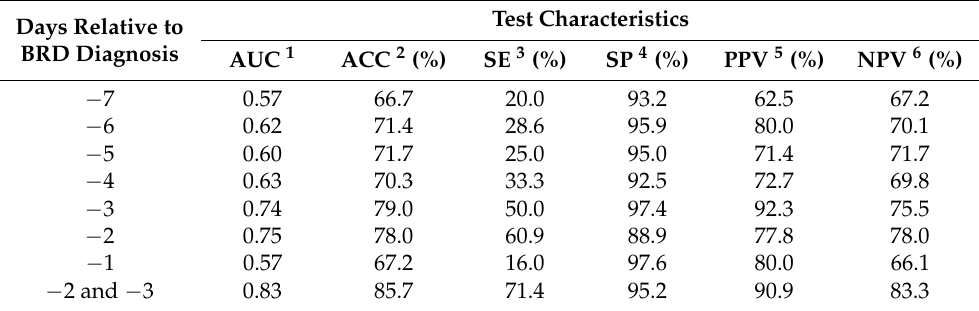
Table 2. Results of the Lasso regularized multivariate logistic regression models to test the adequacy of behavioral parameters as predictive tools for bovine respiratory disease (BRD) in the last 7 days before diagnosis.